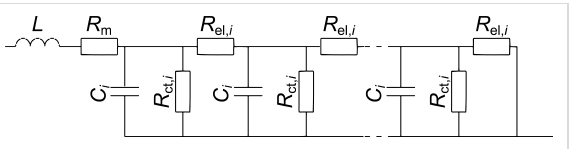
Figure 2: Equivalent circuit with a transmission line for modelling the impedance response of the active